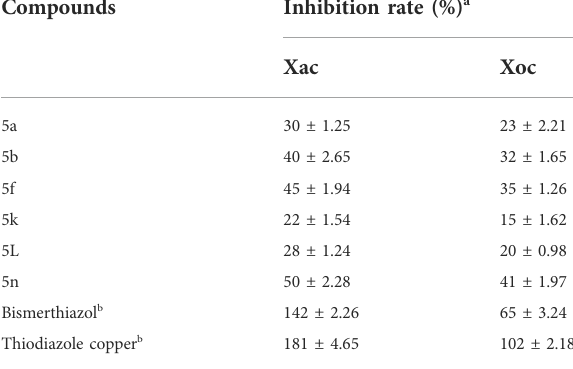
TABLE 2 The EC 50 values of compounds 5a, 5b, 5f, 5k, 5L, and 5n against Xac and